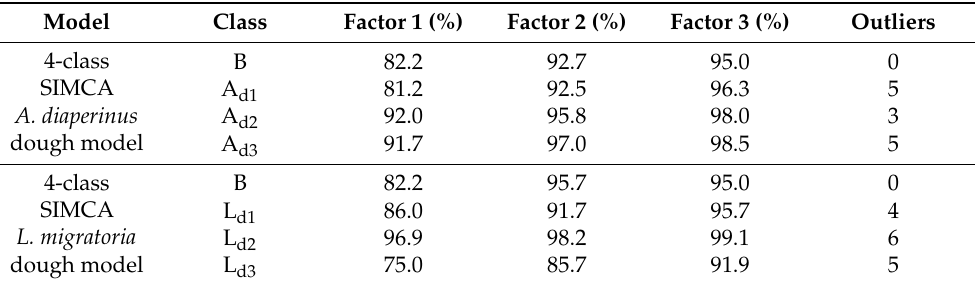
Table 3. The number of factors, their cumulative variance, and the number of outliers used to create 4-class SIMCA models of A. diaperinus and L. migratoria